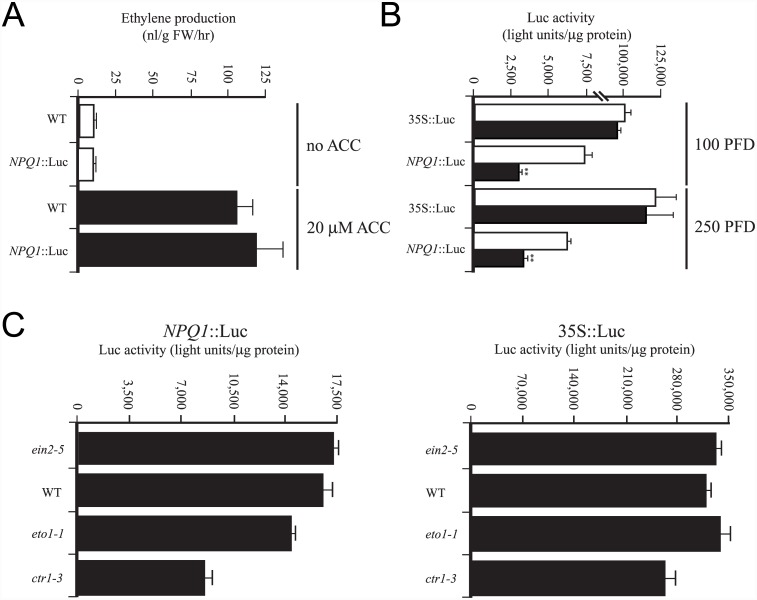
Ethylene represses NPQ1 promoter activity.(A) Ethylene evolution from WT Arabidopsis and transgenic seedlings containing NPQ1::Luc grown for 2 weeks in the absence or presence of 20 μM ACC. (B) Luciferase expression from transgenic Arabidopsis seedlings containing the NPQ1::Luc transgene grown at 100 PFD for 2 weeks in the presence of AgNO3 (white bars) or 20 μM ACC (black bars). Transgenic Arabidopsis containing a 35S::Luc construct was included as a control under the same growth conditions. The same lines grown at 100 PFD were also transferred to 250 PFD for 24 hr prior to assaying. Bars with asterisks indicate significant difference (p < 0.01) relative to the same line grown in the presence of AgNO3. (C) Luciferase expression from of 3 week-old transgenic WT, eto1-1, ctr1-3, and ein2-5 seedlings containing the NPQ1::Luc or 35S::Luc transgenes grown at 250 PFD.